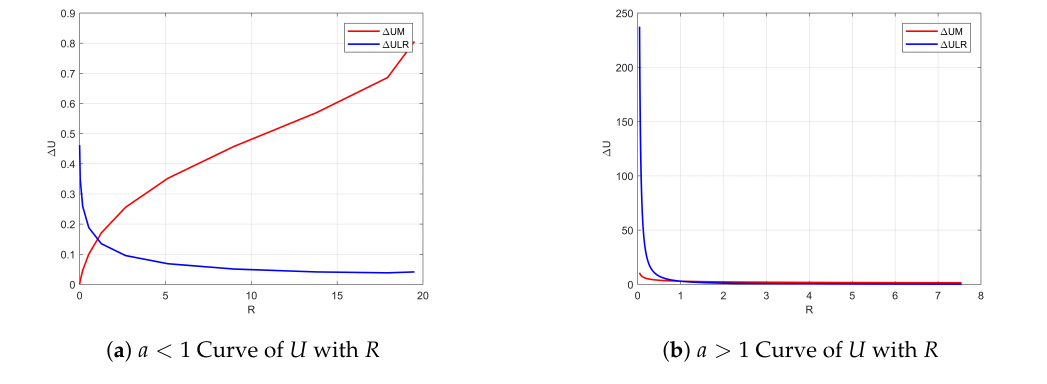
Figure 5. Curve of U with R